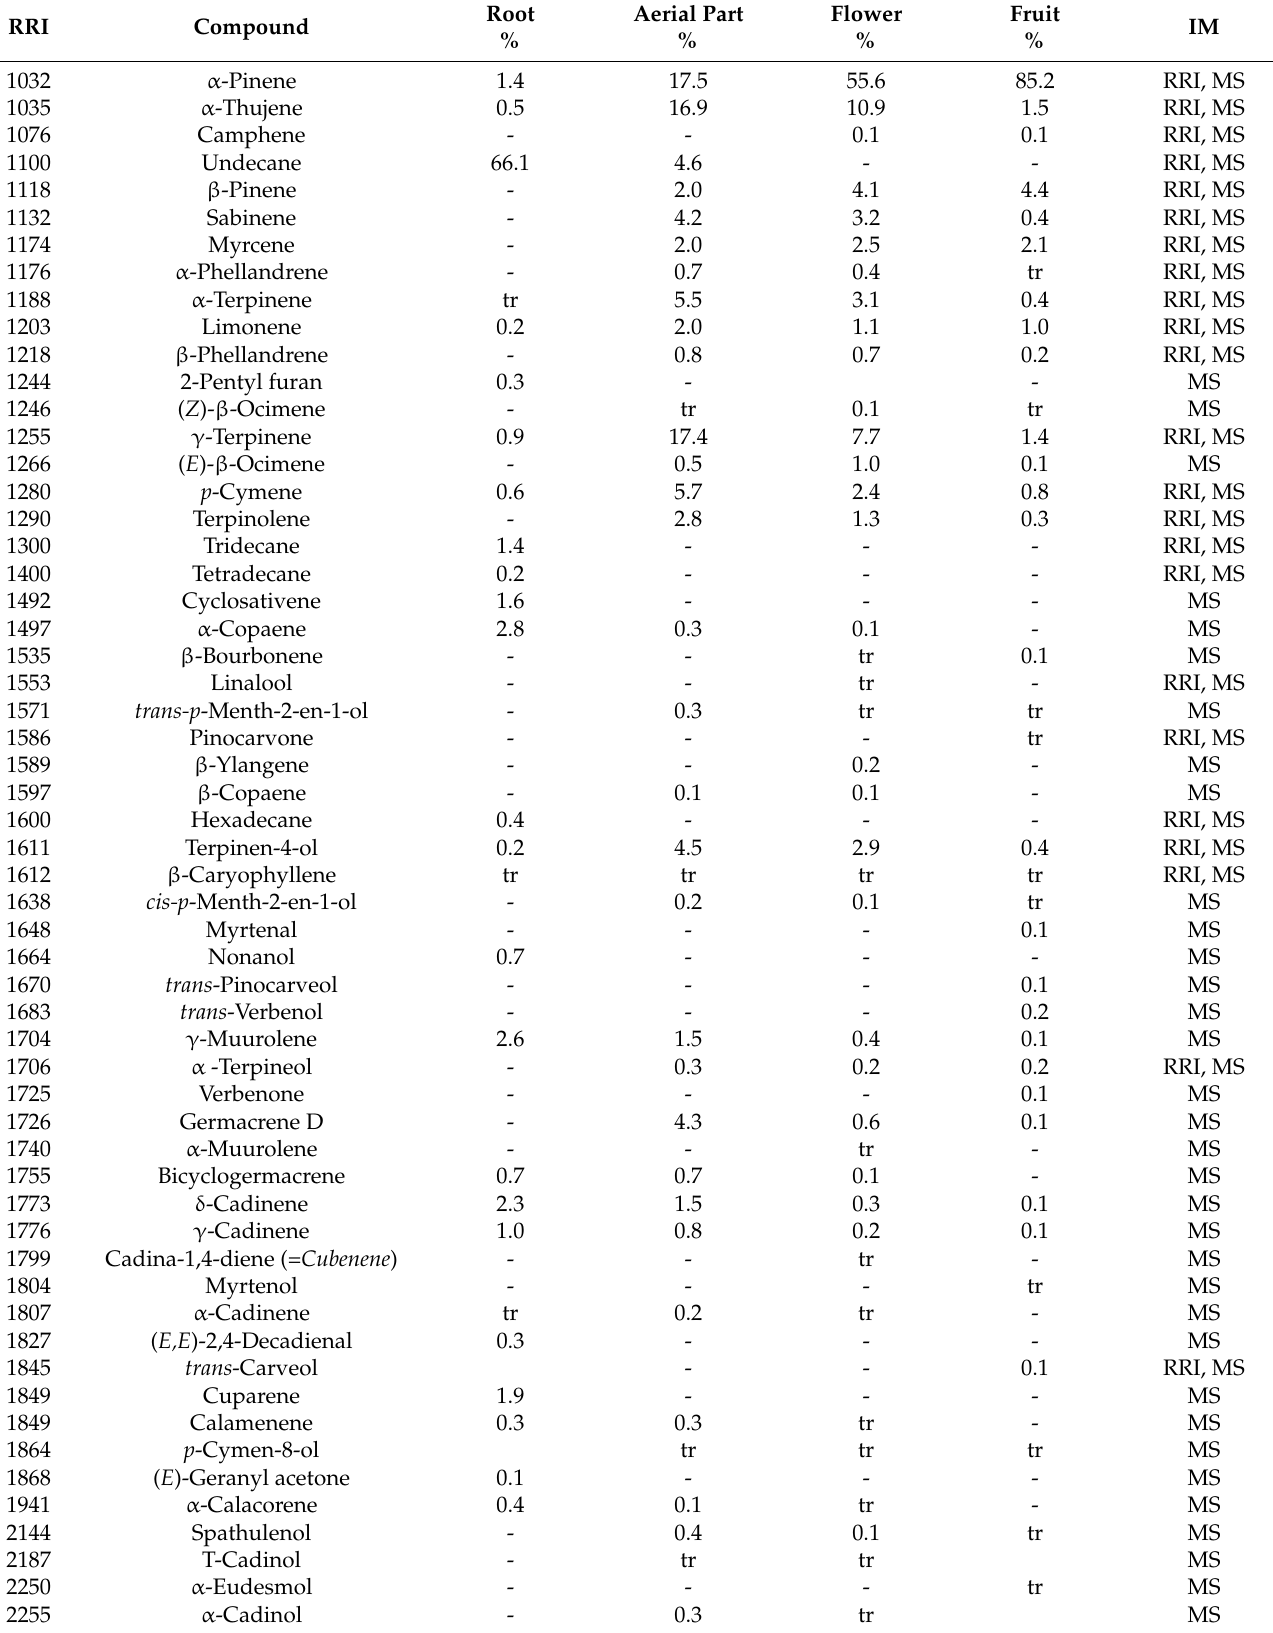
Table 3. The composition of the essential oils of Hypericum scabrum , for different